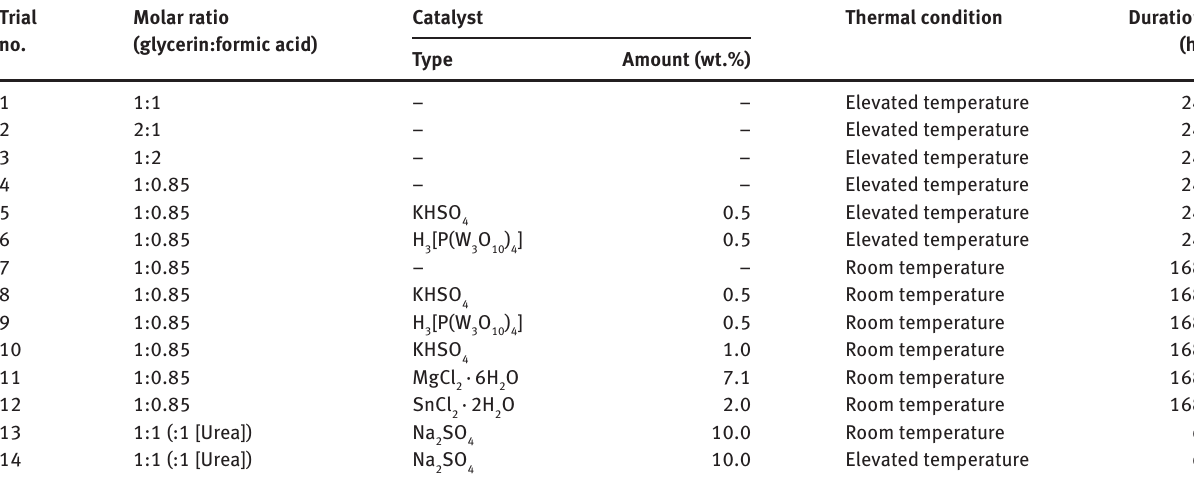
Table 1: Overview of the different conditions under which the experiments were conducted.